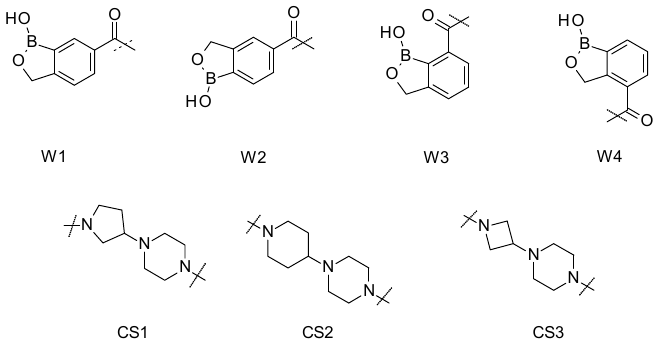
Figure 5. Structures of the warheads (W) and the core spacers (CS).